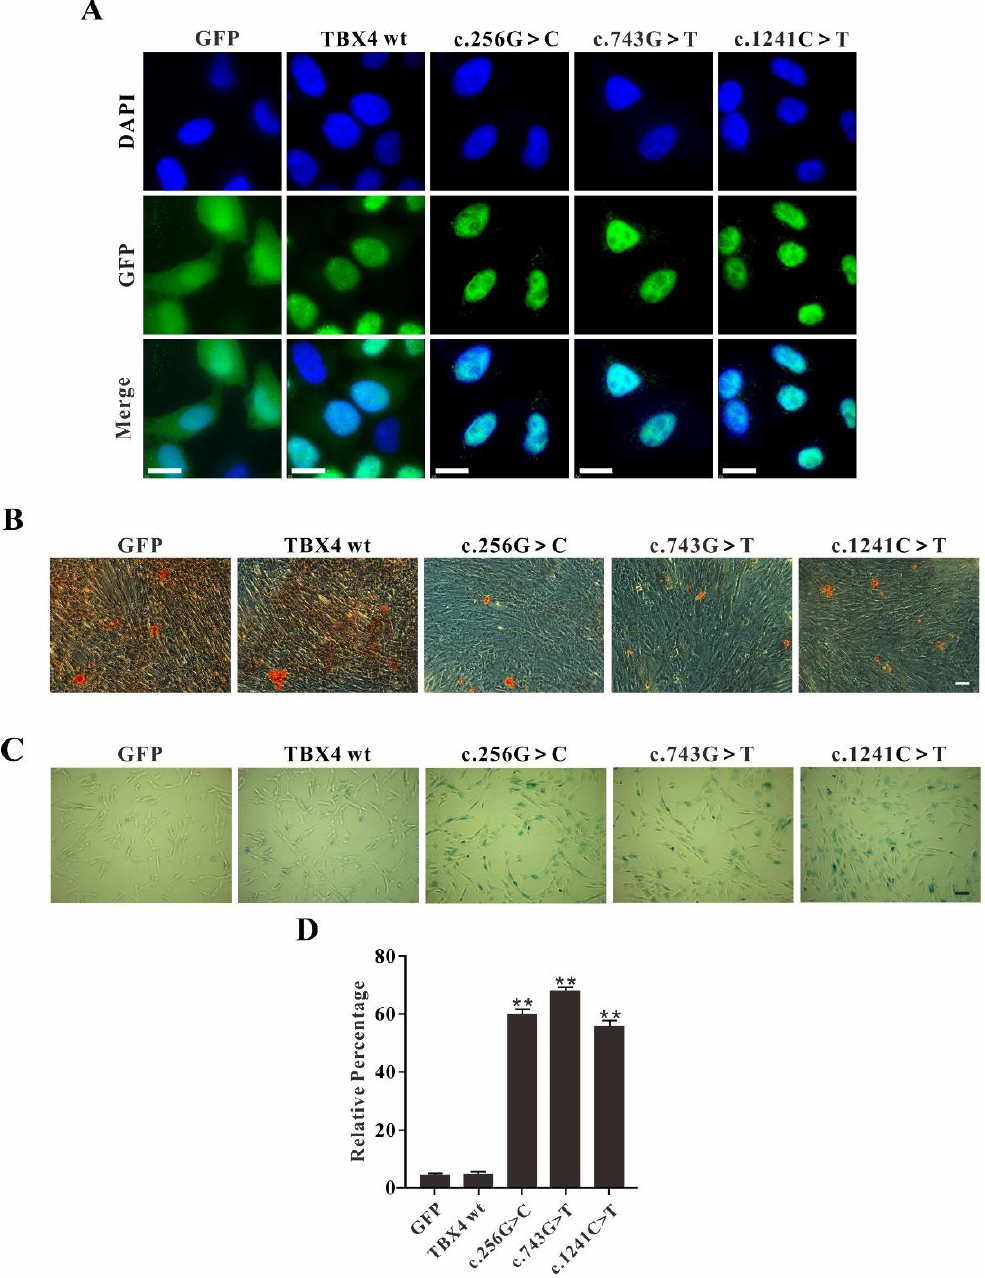
Figure 3. Analysis of TBX4 mutations. ( A ) Localization of TBX4 wt or TBX4 mt GFP fusions in HeLa cells, and GFP was used as control. Bar: 25 μ m. ( B ) Osteogenic differentiation of mesenchymal stem cells (MSCs) overexpression of either TBX4 wt or TBX4 mt . The number of red calcium nodules correlates with the degree of cell differentiation. Bar: 200 mm. ( C ) Visualization of senescence associated β -galactosidase staining between wild-type and mutant TBX4 transfected cells. X-Gal was used as a substrate for β -galactosidase, and dark blue products inside cells were produced when catalyzed by aging-specific β -galactosidase. Examination for staining was performed after overnight incubation under bright field microscopy at 200x magnification. Bar: 200 mm. ( D ) Statistics of senescence associated β -galactosidase assay. The blue cells were counted, and the percentages of blue cells in total were calculated. SPSS was applied for statistics analysis (** p < 0.01).